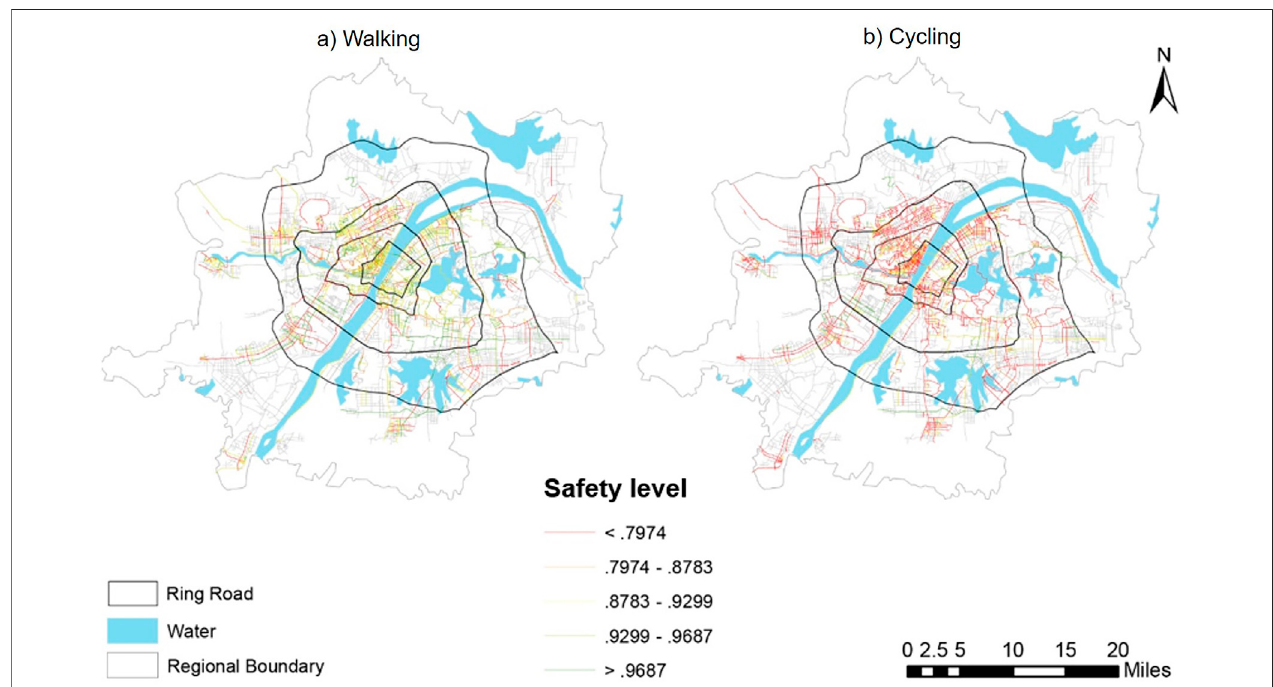
FIGURE 6 | Spatial disparity ATTS in the ring road level.